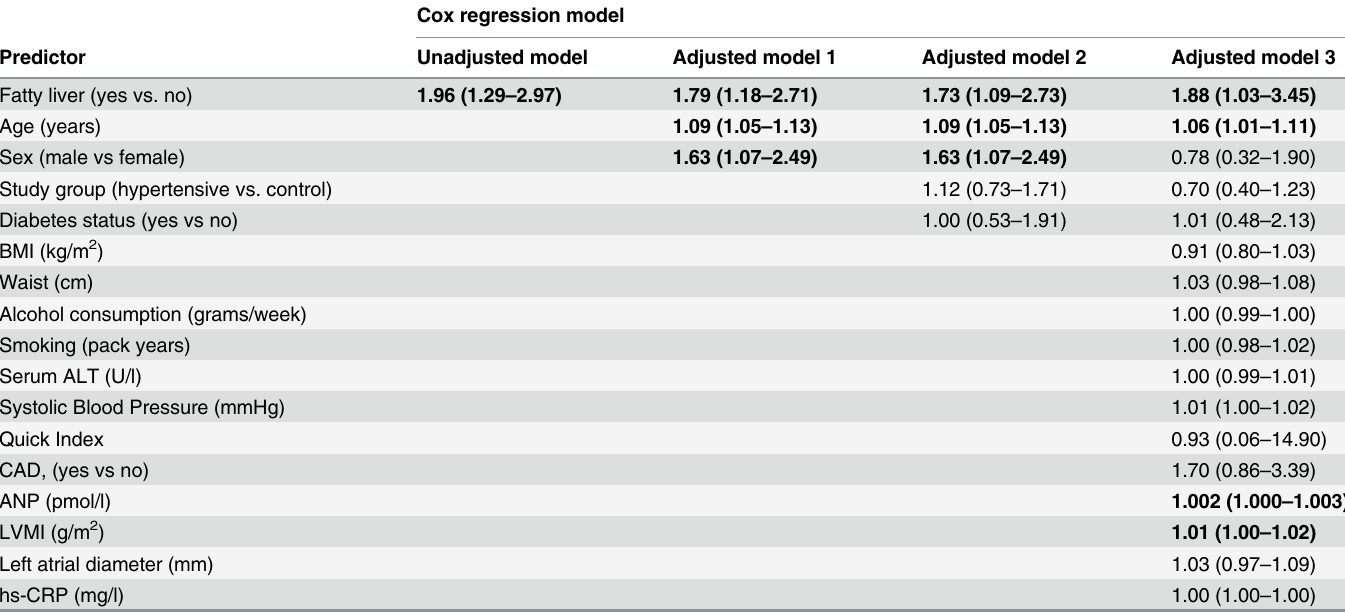
Table 3. Association between NAFLD (n = 958) and risk of AF during